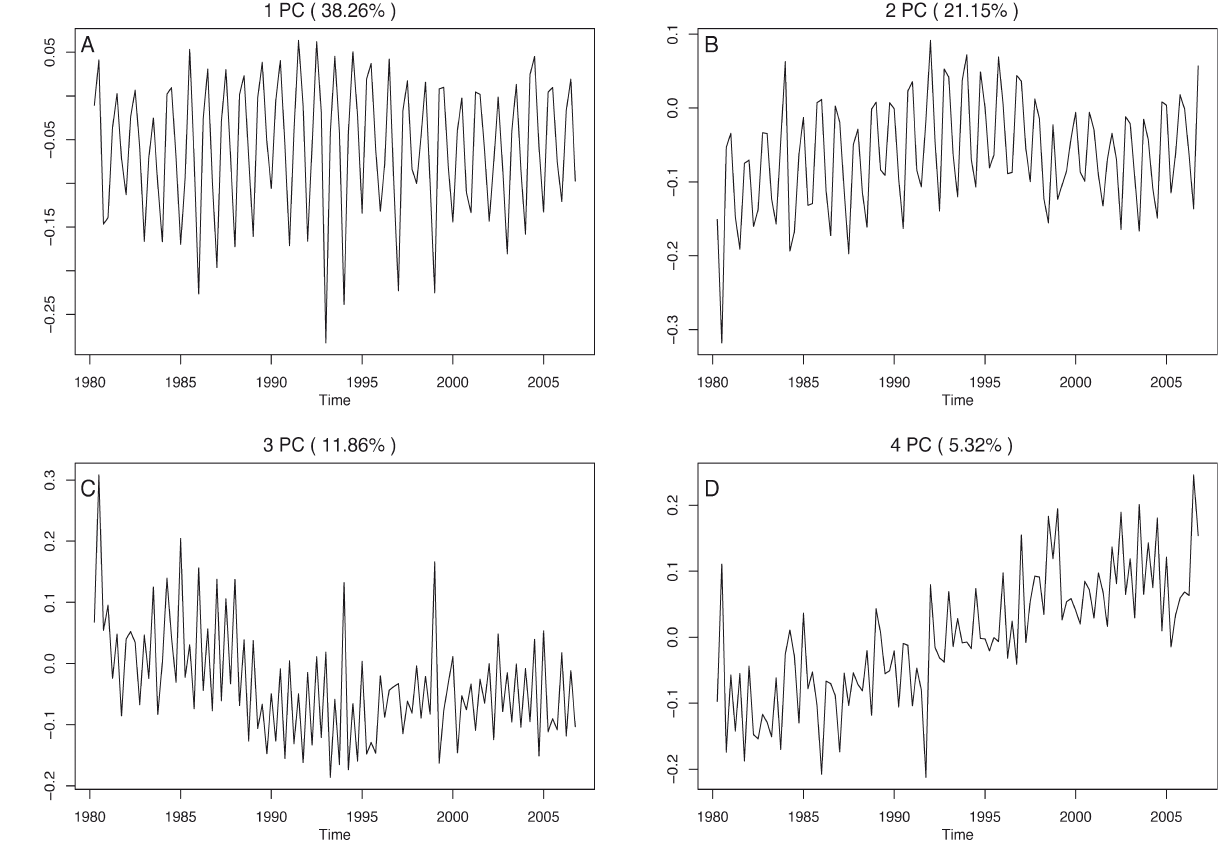
Fig . 2. – Time series of the main four PCs (catches are shown in a logarithmic scale).